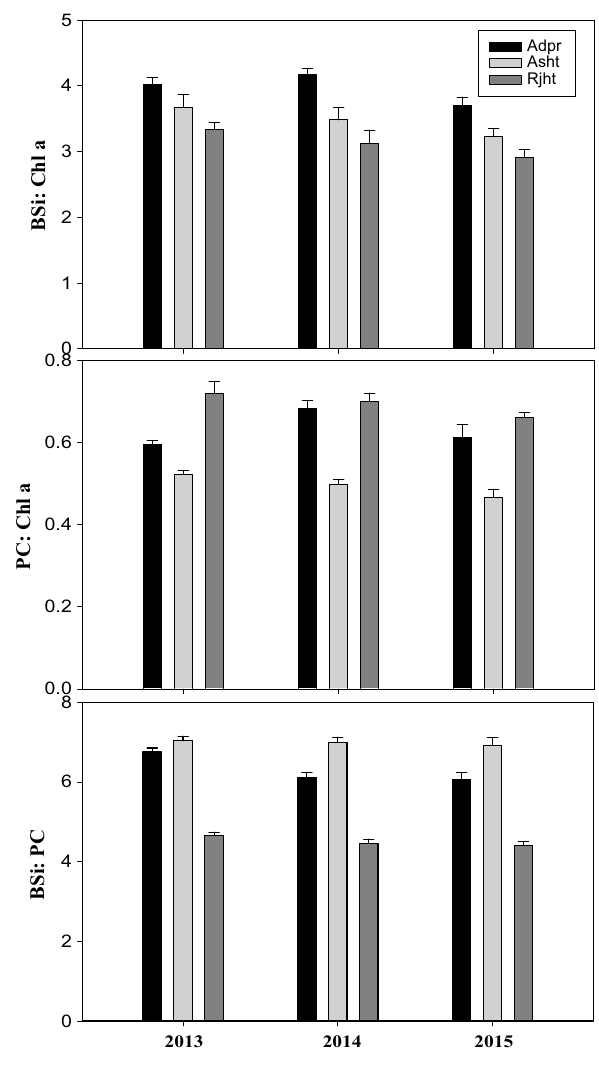
Fig. 7 Spatiotemporal trends in ratio of productivity variables at study sites in the Ganga River during low